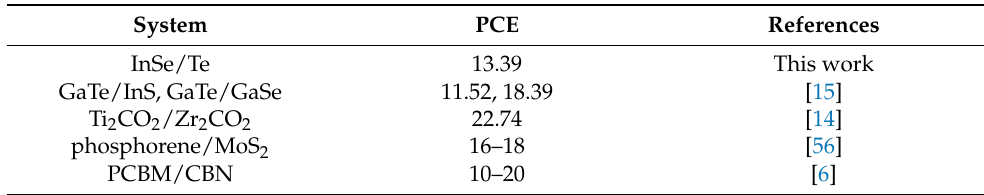
Figure 6. Simulated solar cell power conversion efficiency (PCE) η for InSe/Te heterostructure (marked as the red star). Table 2. Calculated maximum power conversion efficiency (PCE) (%) of some recently reported 2D heterostructure solar